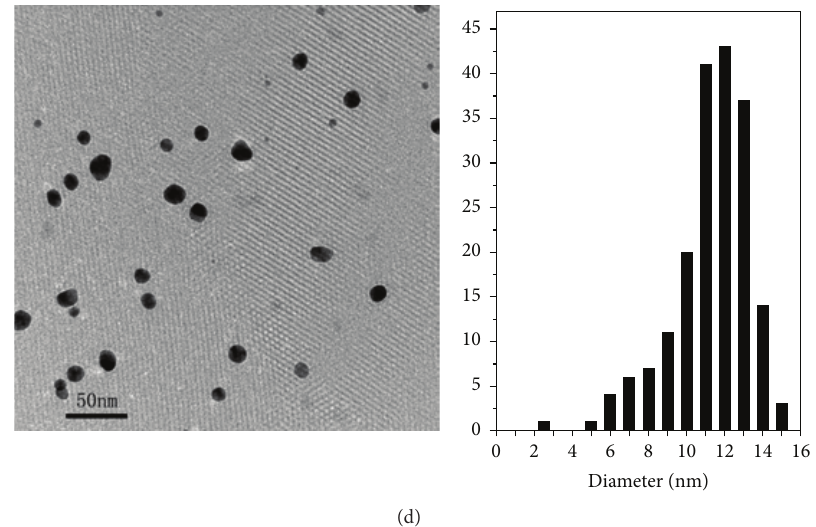
Figure 2: TEM images and size distributions for (a) Au-1, (b) Au-2, (c) Au-3, and (d) Au-4 catalysts.